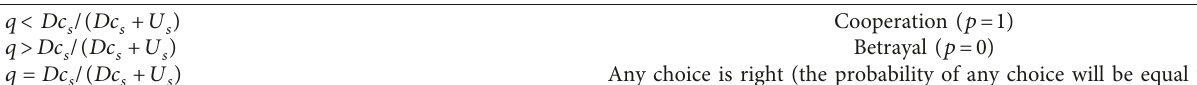
Figure 2: Profit matrix of capital provider and capital demander. Table 1: Optimal response strategy of the capital